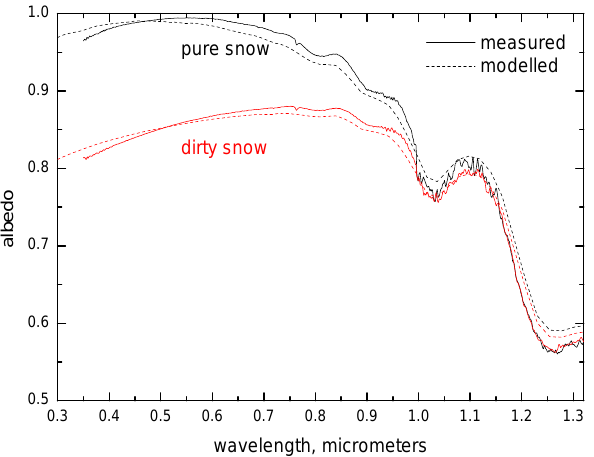
Fig. 2. The spectral dependence of snow spherical albedo at c = 2 . 5µgg − 1 and a ef = 55µm. The results of calculations are given by broken lines. Solid lines represent experimental measurements for artificial snow composed of nearly spherical ice crystals (Brandt et al., 2011).